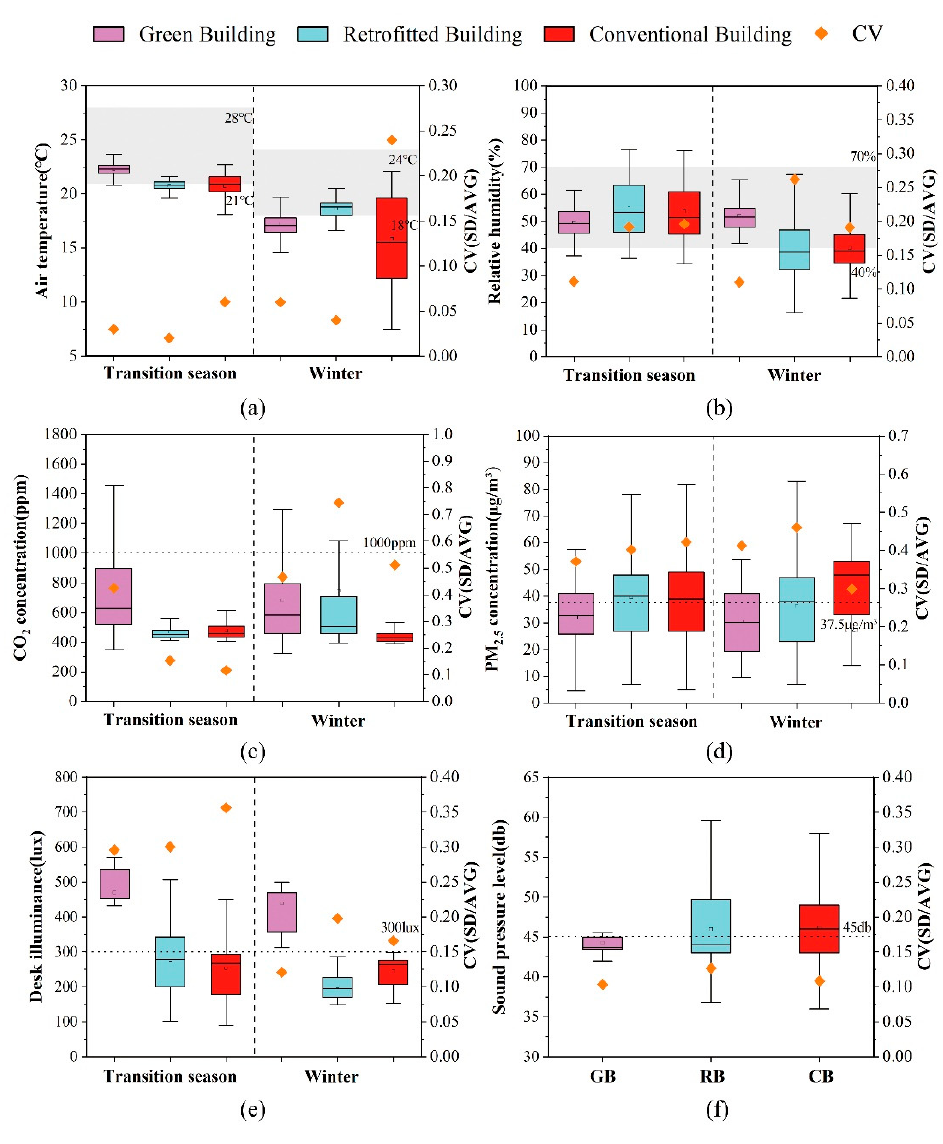
Figure 4. Comparison of ( a ) air temperature, ( b ) relative humidity, ( c ) CO 2 concentration, ( d ) PM 2.5 concentration, ( e ) desk illuminance, and ( f ) A-weighted sound pressure level in the GB, RB, and CB.